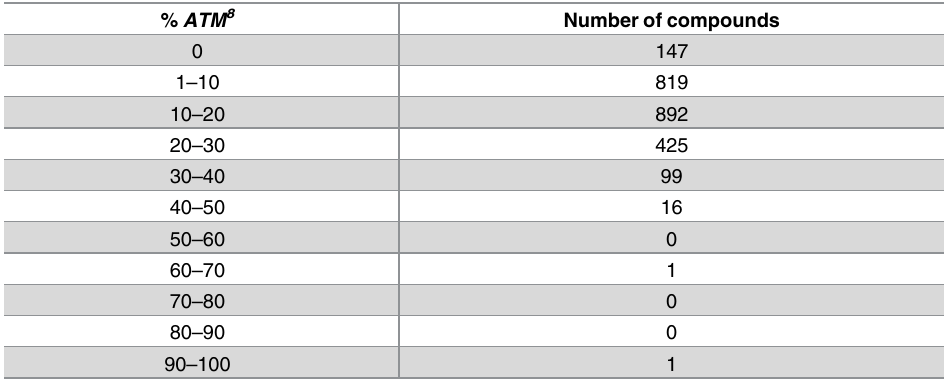
Table 2. Overview of the primary